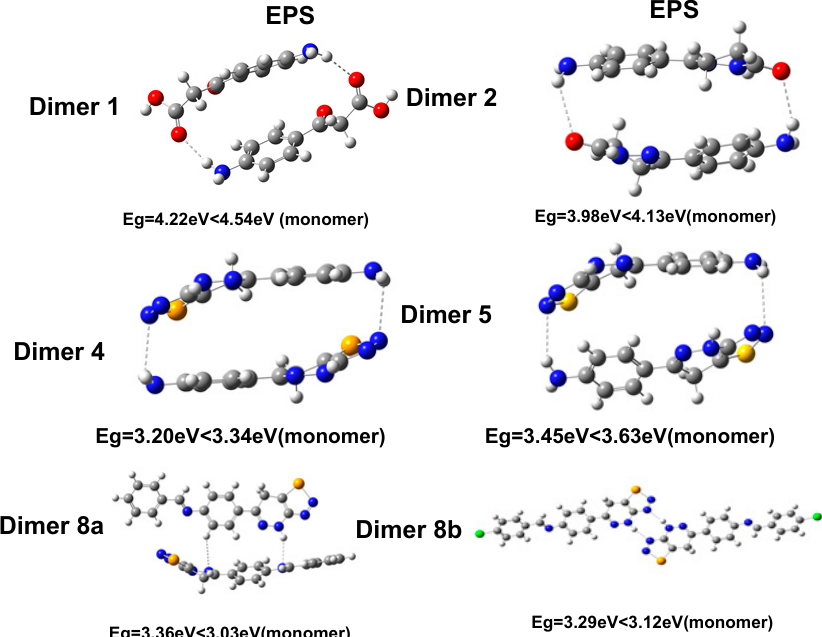
Scheme 5. Optimized dimer structure and their energy